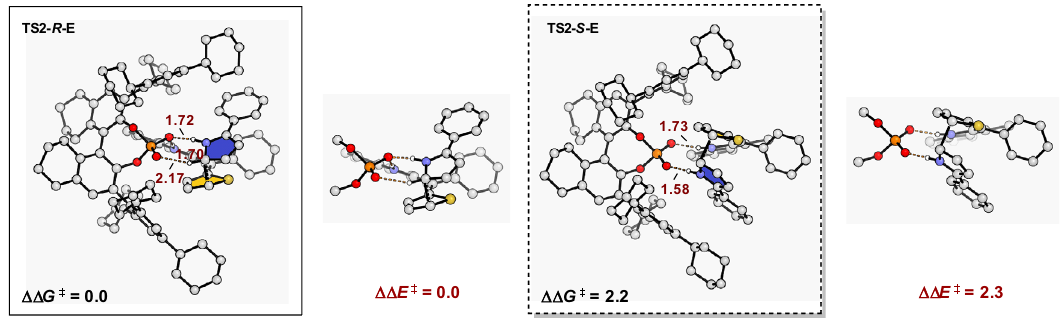
Fig. 4 DFT-optimized chiral phosphoric acid catalyzed transition states TS2-R-E and TS2-S-E. The distances are given in Ångstroms, and energies are given in